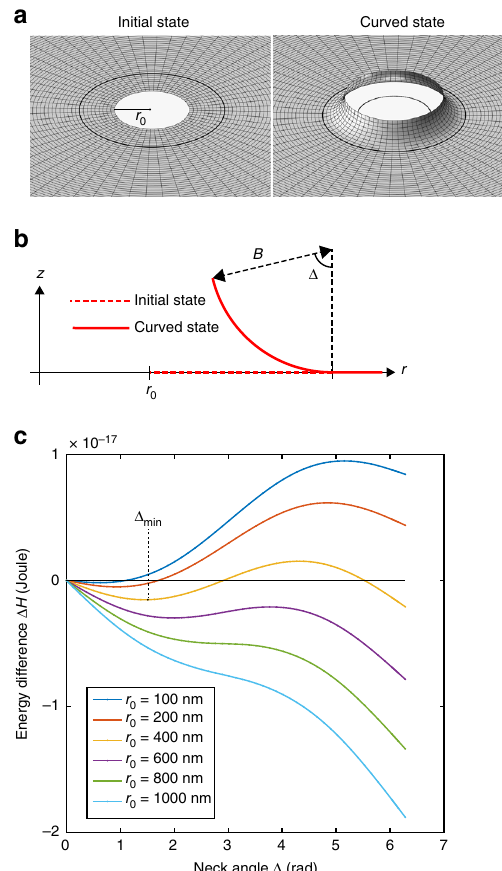
Fig. 4 Biophysical model for ANXA4-induced curvature during repair. a Initial and curved state of a circular membrane hole. The solid area inside the solid circle is the region contributing to the change in curvature elastic energy between the initial and curved states. b Pro fi le of the neck and de fi nitions: initial hole radius r 0 , the neck angle Δ and curvature radius B . c Energy difference Δ H as a function of Δ for varying values of the initial hole size. When r 0 is below a critical hole radius r 0 * there is a minimum in Δ H corresponding to a energetically favored neck angle Δ min. In the plot r 0 ≈ 800 nm. For r 0 > r 0 *, Δ H decreases monotonically with Δ meaning that continuous rolling is favored (also, see Supplementary Notes 1 and 2